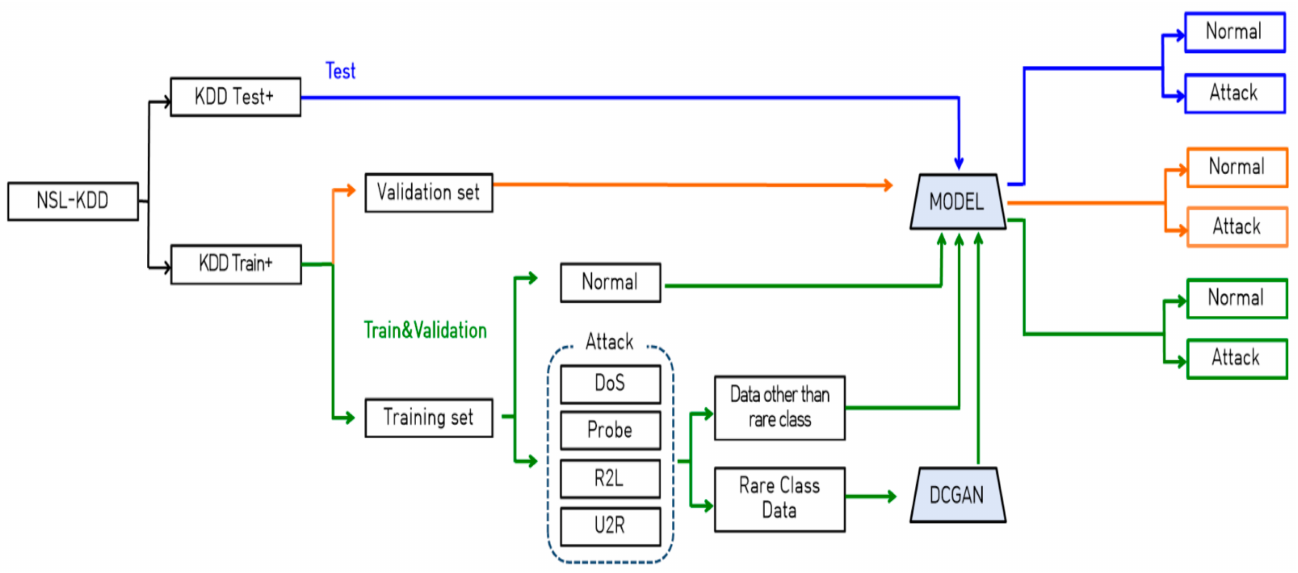
Figure 2. Structure of the